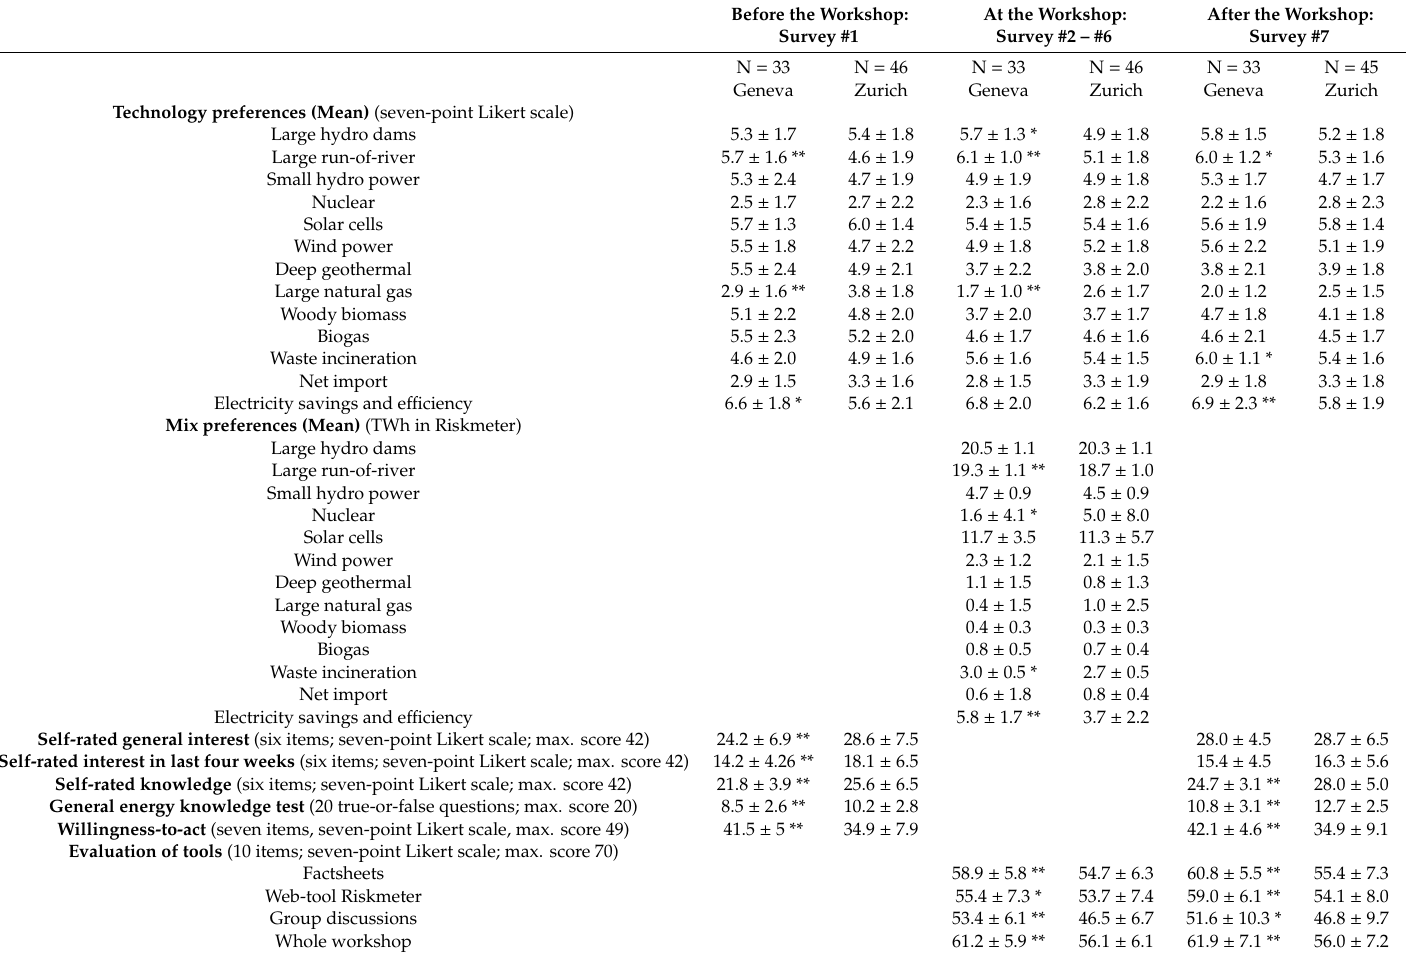
Table 2. Comparison between informed citizen panels in Geneva and